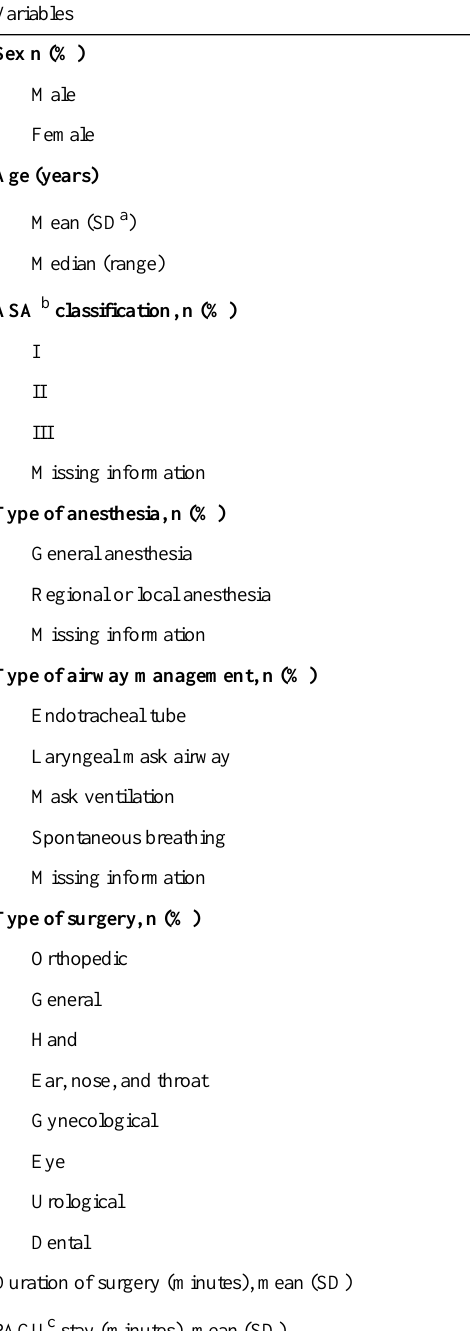
Table 1. Participants’demographic variables, and surgical and anesthetic factors